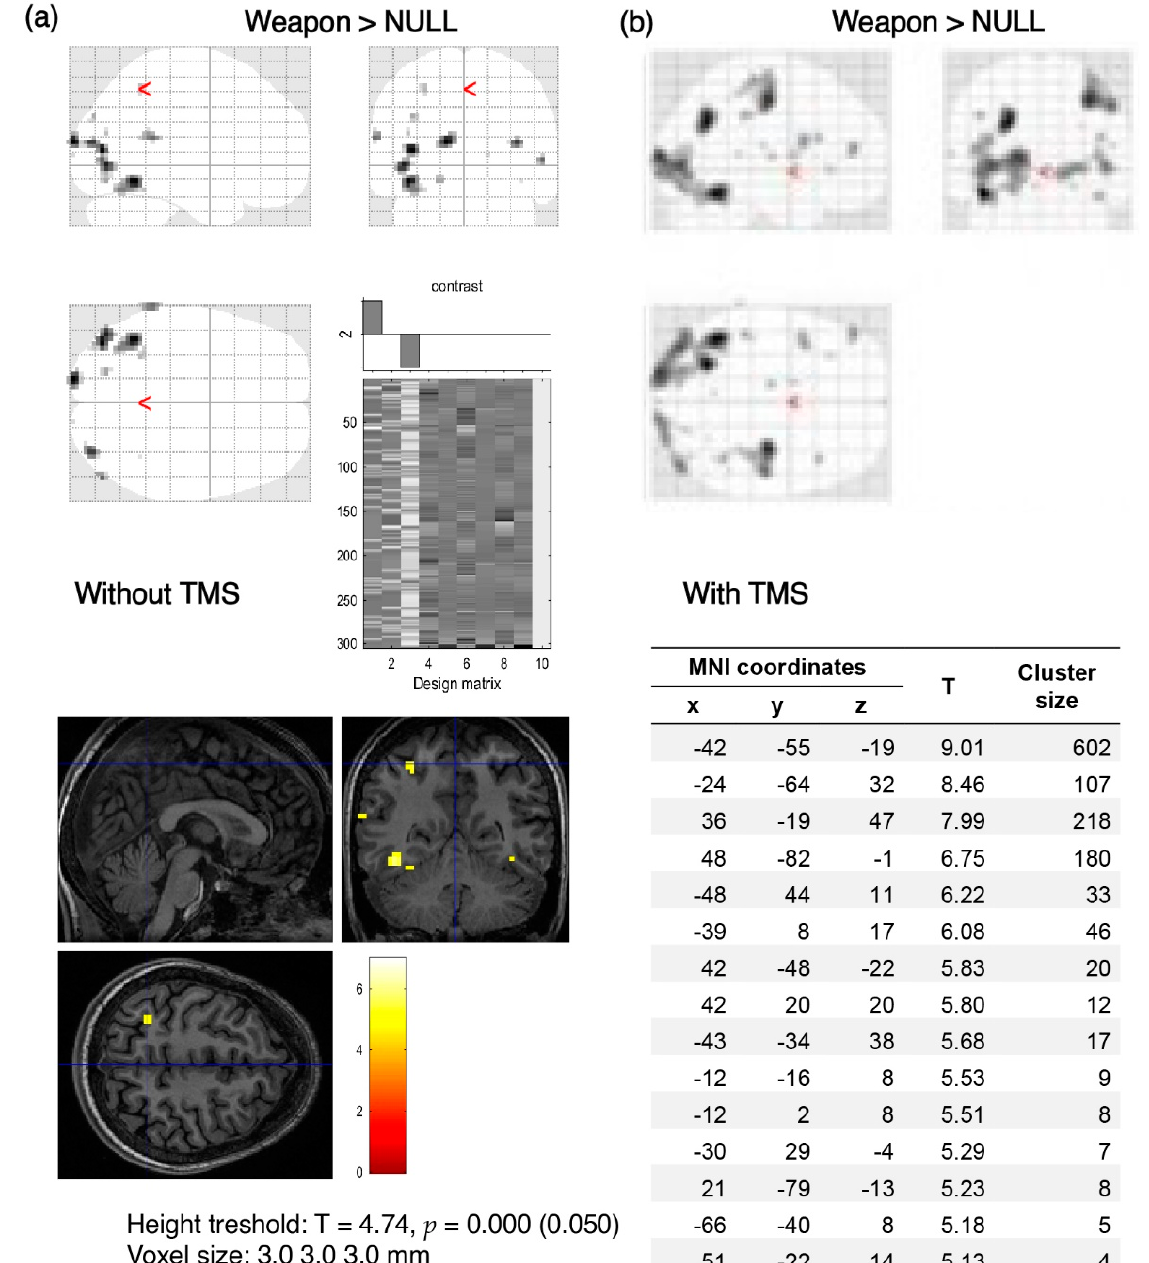
Figure 6. One of two cases of the subjects that shows a decrease in activation of the BOLD signal ( n = 2) in response to the visual stimulus of significant significance without TMS ( a ) compared to visual stimulus after transcranial magnetic stimulation ( b ). The visibly clear increase in the BOLD signal in the occipital region after applying TMS. Table shows 3 local maxima more than 8.0 mm apart. “Weapon” denotes activations evoked by images related to the military compared to brain activation when no stimuli were presented (NULL).